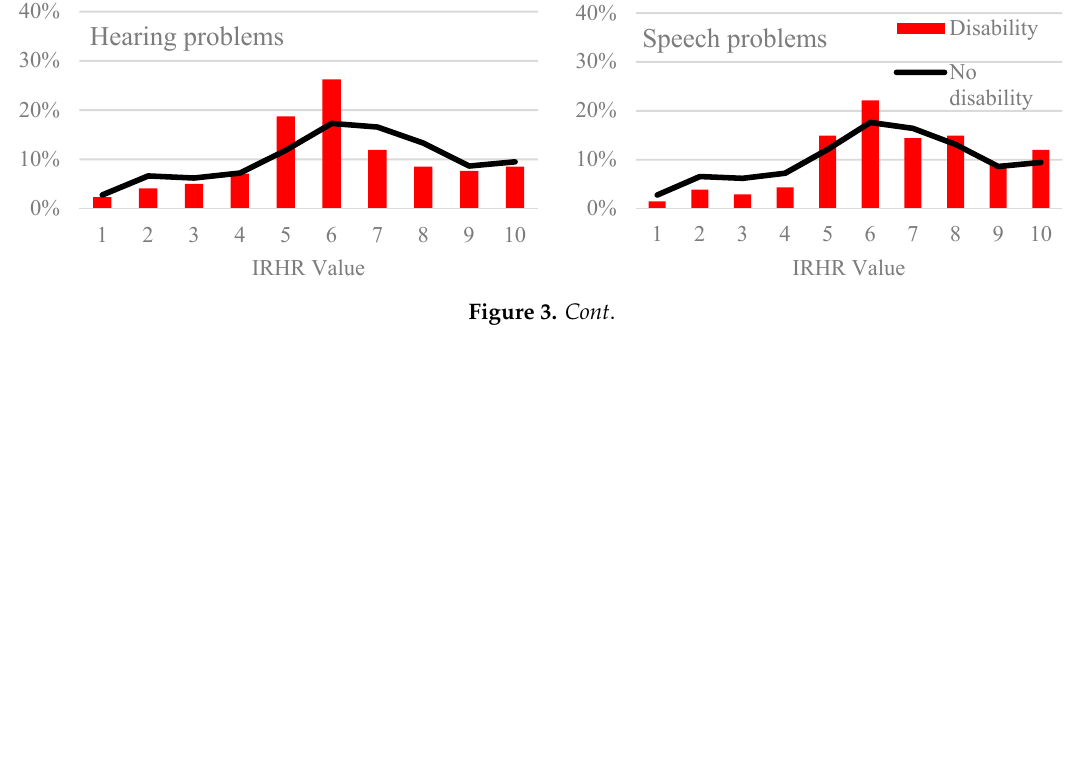
Figure 2. Index of Relative Homelessness Risk by all disability and long-term conditions versus no impairment (pre-NDIS).